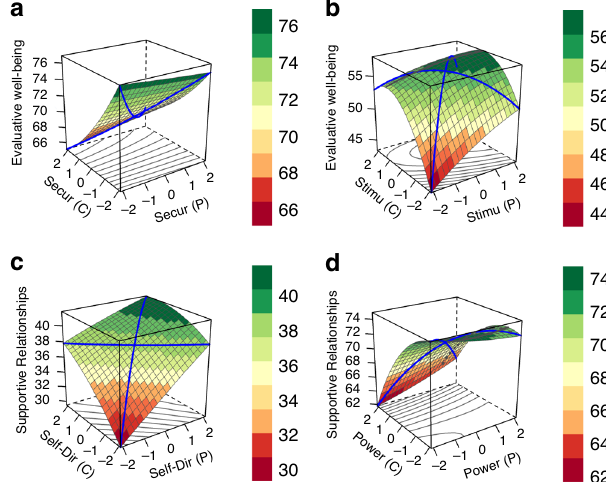
Fig. 3 Actual associations between values and well-being. Four response surface plots based on the multilevel polynomial regression results with individual- (P) and country- (C) level values as predictors, including control variables, for security ( a ), stimulation ( b ), self-direction ( c ), and power ( d ) values. Predictors were standardized for illustrative purposes. Source data are provided as a Source data fi